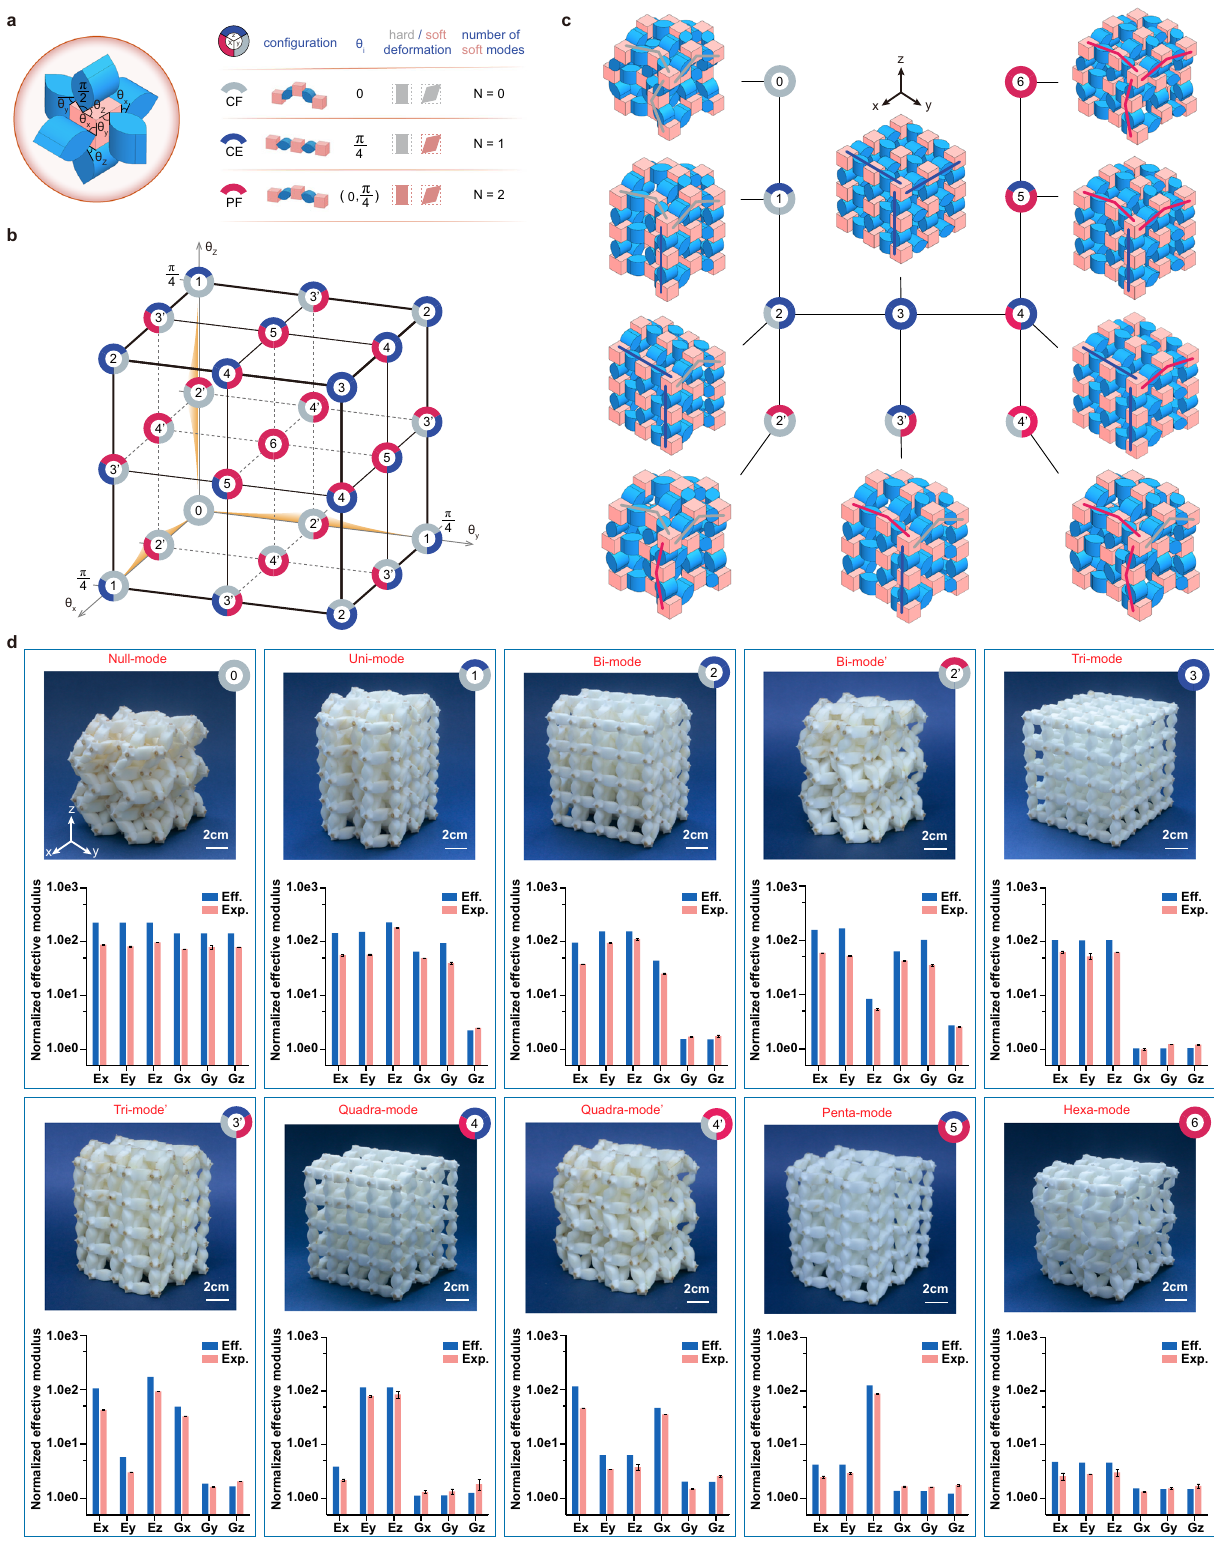
Fig. 3 | Schematic diagram of the 3D mechancial metamaterial ’ s transform- ability from null-mode to hexa-mode and its experimental validation. a The three basic con fi gurations (gray-colored CF, blue-colored CE and red-colored PF), foldingangles( θ i=x,y,z canbe 0, π /4orin-between), the deformationtypes (hard or soft) and the corresponding number of zero modes. b A coordinate space which illustrates the 3D tessellation ’ s all possible combinations of the edge linkages and the corresponding types of the equivalent extremal metamaterials (0=null-mode,